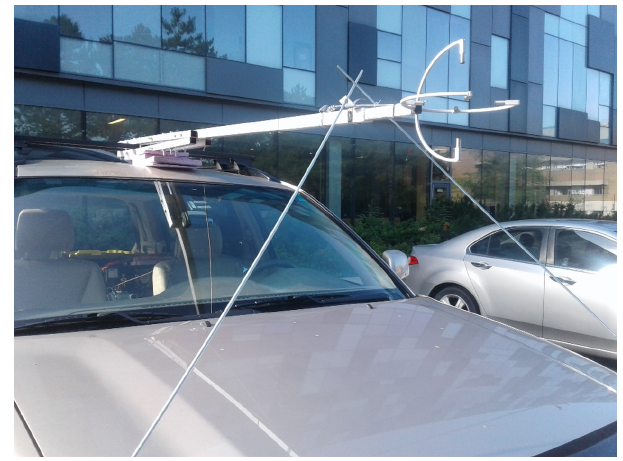
Figure 1. A front view of instrumented car (also referred to as a mobile car platform or mobile car laboratory) used in this investi-